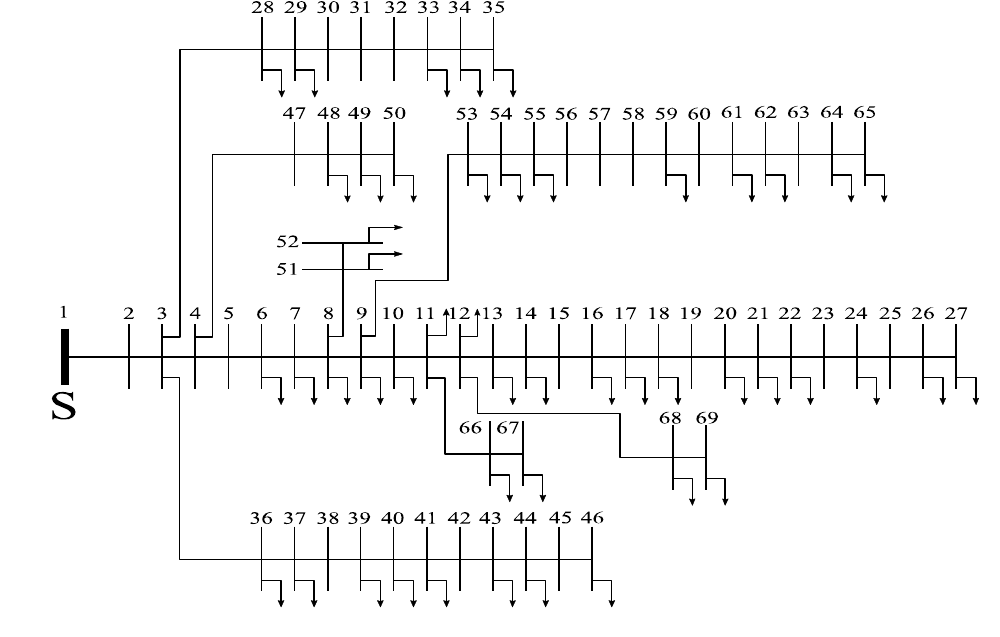
Figure 11. 69-Bus distribution test system.